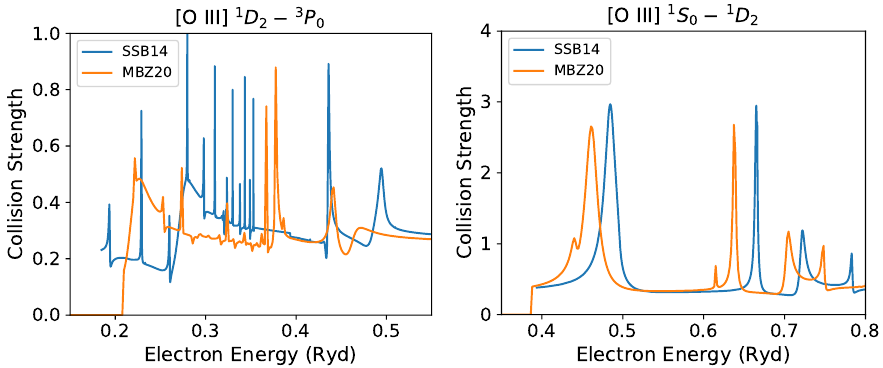
Figure 12. Collision strength for the transitions [O III ] 1 D 2 − 3 P 0 (left panel) and 1 S 0 − 1 D 2 (right panel) computed by SSB14 and